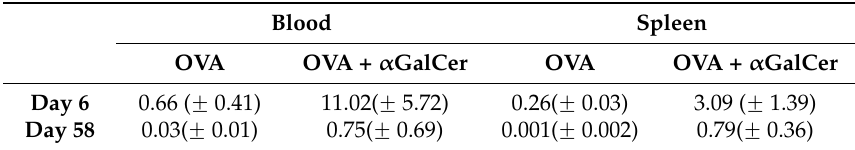
Figure 1. IN vaccination preferentially induces OVA specific CD8 + T cells in FRT. Plots show frequency of OT-I T cells among CD8 + T cells present in FRT, intestinal intraepithelial lymphocytes (IEL), lamina propria (LP),spleen (SP), and cervical LN(cLN) six days after IN vaccination with either Table 1. Average frequency ( ˘ std. dev) of antigen specific CD8 + T cells detected in immunized mice. OVA plus α GalCer or OVA alone. Blood Table 1. Average frequency (± std. dev) of antigen specific CD8 + T cells detected in immunized mice. Blood Spleen OVA